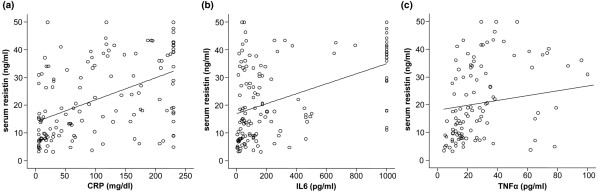
Correlation of serum resistin to biomarkers of inflammation in critically ill patients. Serum resistin is strongly correlated with (a) C-reactive protein CRP (r = 0.510, P < 0.001), (b) IL-6 (r = 0.477, P < 0.001), and (c) TNF-α (r = 0.509, P < 0.001). Spearman rank correlation test.